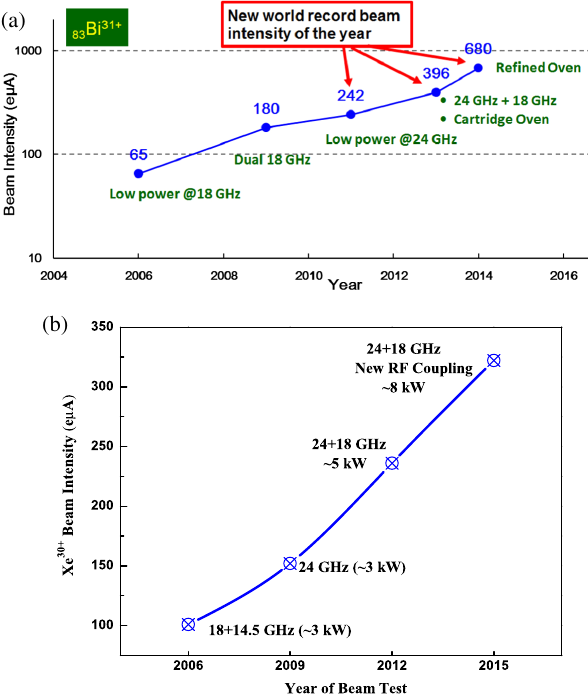
FIG. 22. 209 Bi 31 þ (a) and 129 Xe 30 þ (b) beam intensity evolution with different technical developments from the year 2006 to 2015.